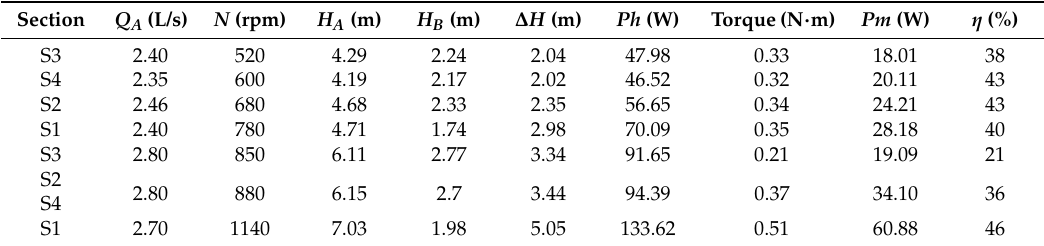
Table 2. Experiments in the pump as turbine (PAT) for different rotational speeds with ultrasonic doppler velocimetry (UDV) data acquisition from S1 to S4